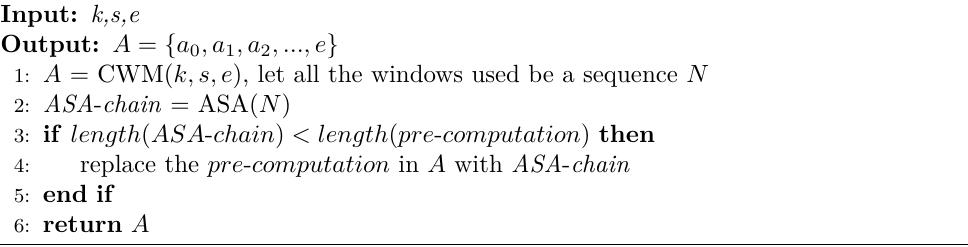
Algorithm 7 Cross Window method with the Addition Sequence